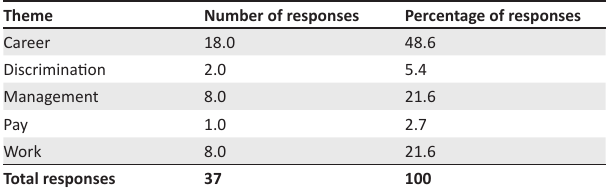
TABLE 13: Content cluster of individuals.